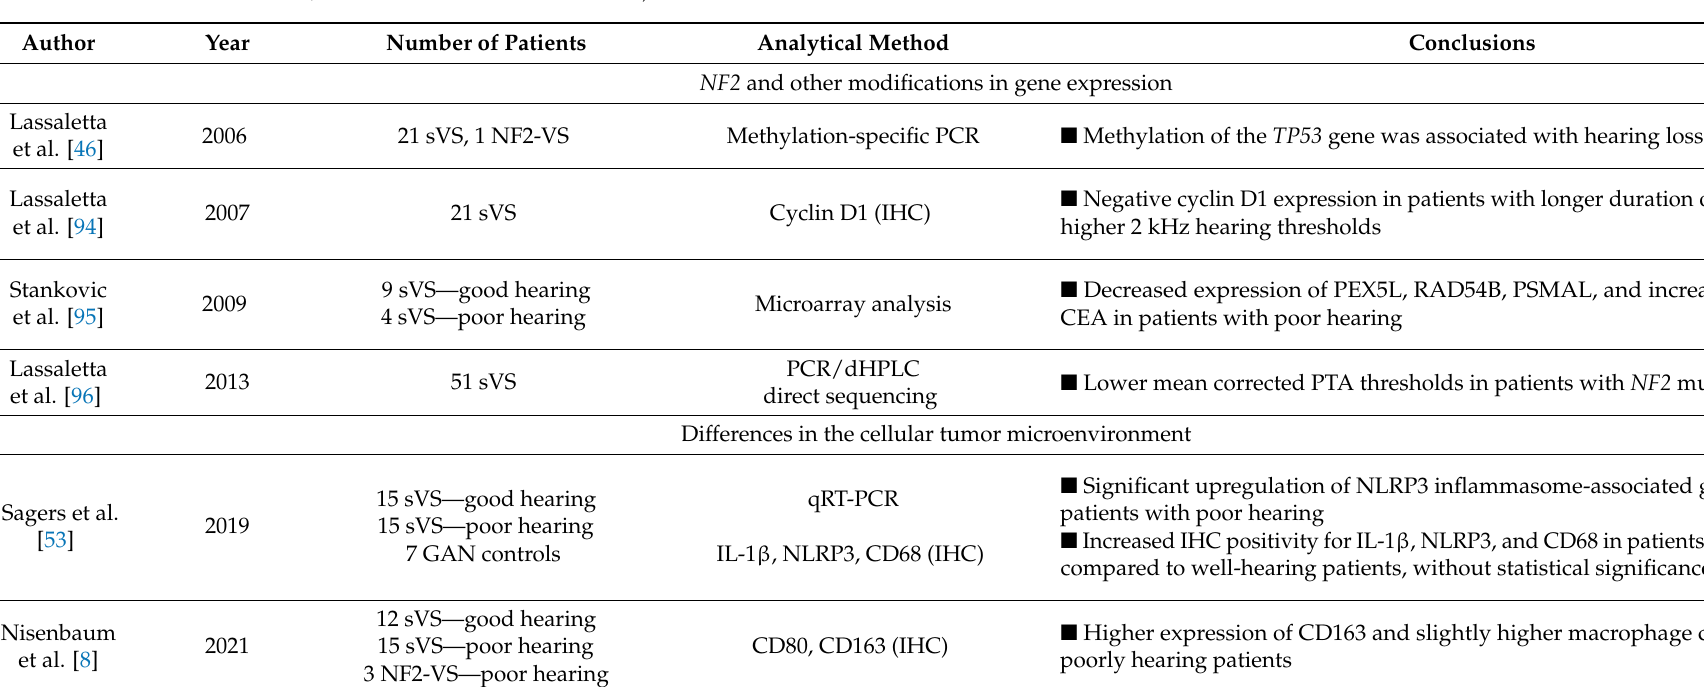
Table 2. Relationship of the biology and microenvironment of VS to hearing loss—literature overview. (sVS—sporadic VS; NF2-VS—VS associated